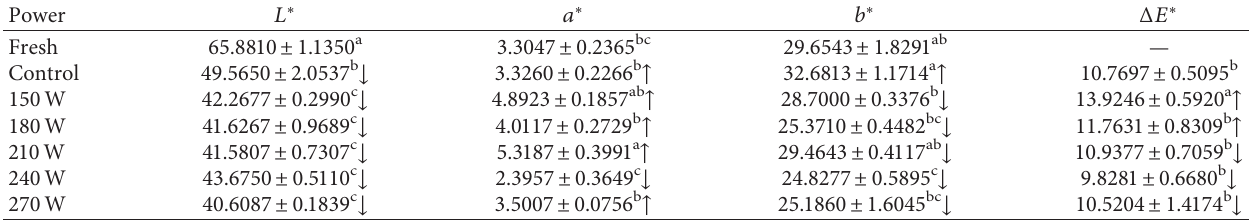
Table 2: Color difference changes in potatoes before and after drying under different ultrasonic power pretreatment conditions. Power